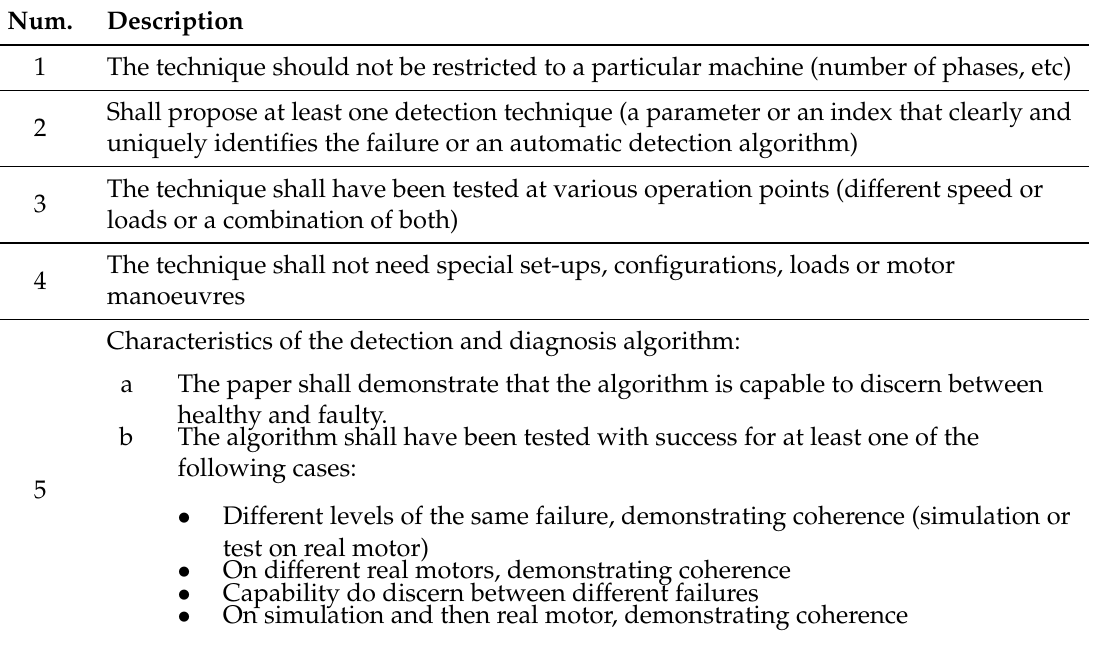
Table 8. Inclusion Criteria [1].